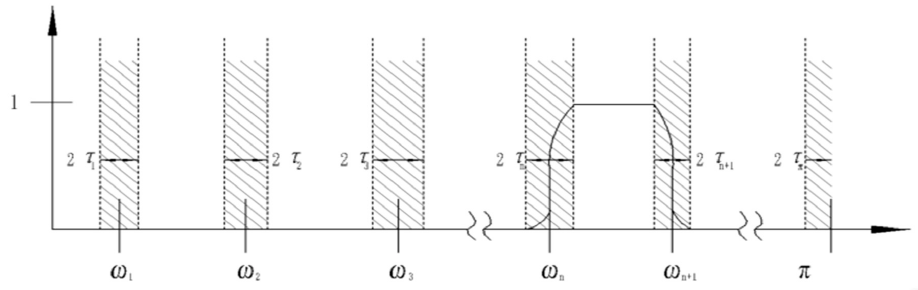
Figure 2. Segments of the Fourier axis .